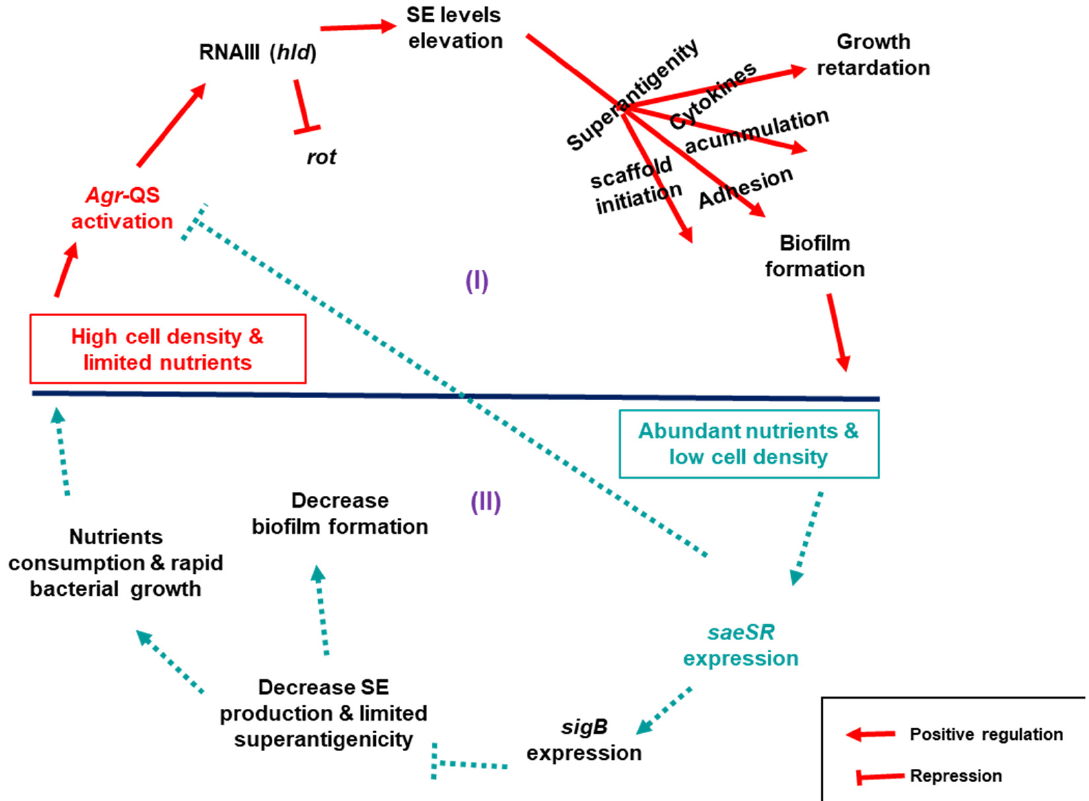
Figure 7. Proposed scenarios through which saeSR , sigB , and Agr -QS regulate SEs modulation of S. aureus growth and biofilm development in PCs. (I) High cell density & nutrient deficiency enviro- ment: Agr-QS is activated, signaling toxin expression by repressing rot through its effector RNAIII ( hld ), leading to growth retardation and biofilm matrix initiation, cell-to-cell adhesion, and biofilm development via superantigenic activity. (II) Nutrient abundance in low cell density environment: saeSR positively regulates the expression of sigB , which represses Agr-QS that consequentially decrease toxin production, enhancing rapid bacterial cells proliferation until the cell density increases again and Agr-QS is activated. Decrease in SE production reduces superantigenicity and, consequentially, biofilm